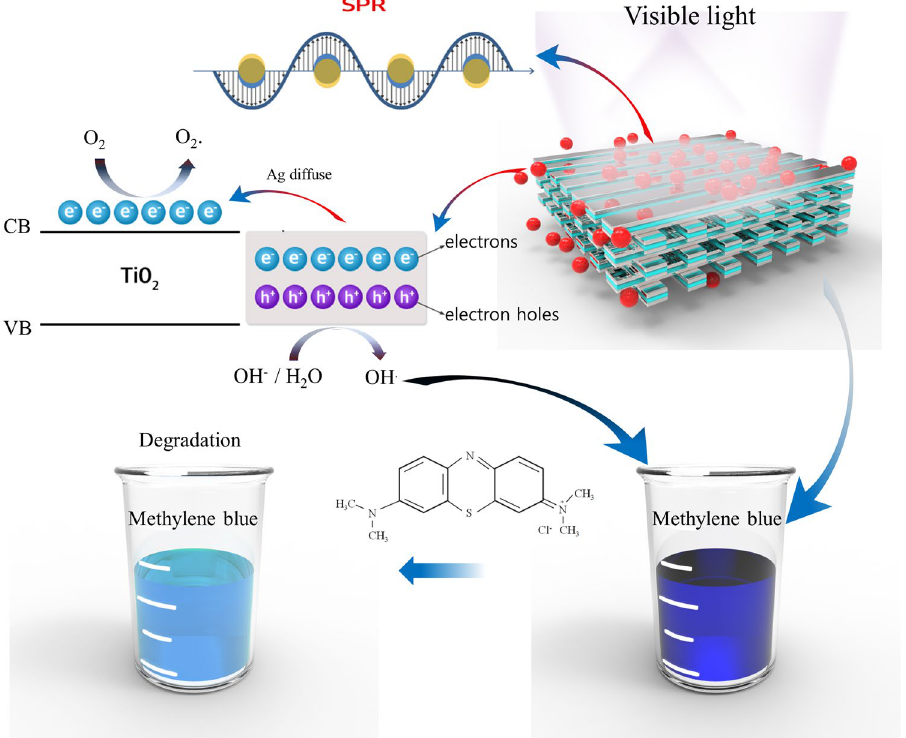
Figure 1. Mechanism of the Ag/TiO 2 nanocomposite architecture. Electrons and holes in the Ag/TiO 2 nanocomposite cross structure enhance the photocatalytic reaction by the SPR phenomenon under visible-light irradiation. Under visible light, generated electrons react with oxygen molecules to form superoxide radicals (O 2 − ∙ ) and the holes in the surface of the metal layer react with hydroxyl groups to form hydroxyl radicals (OH ∙ ). Superoxide and hydroxyl radicals can participate in various chemical reactions with all biological molecules, organic or